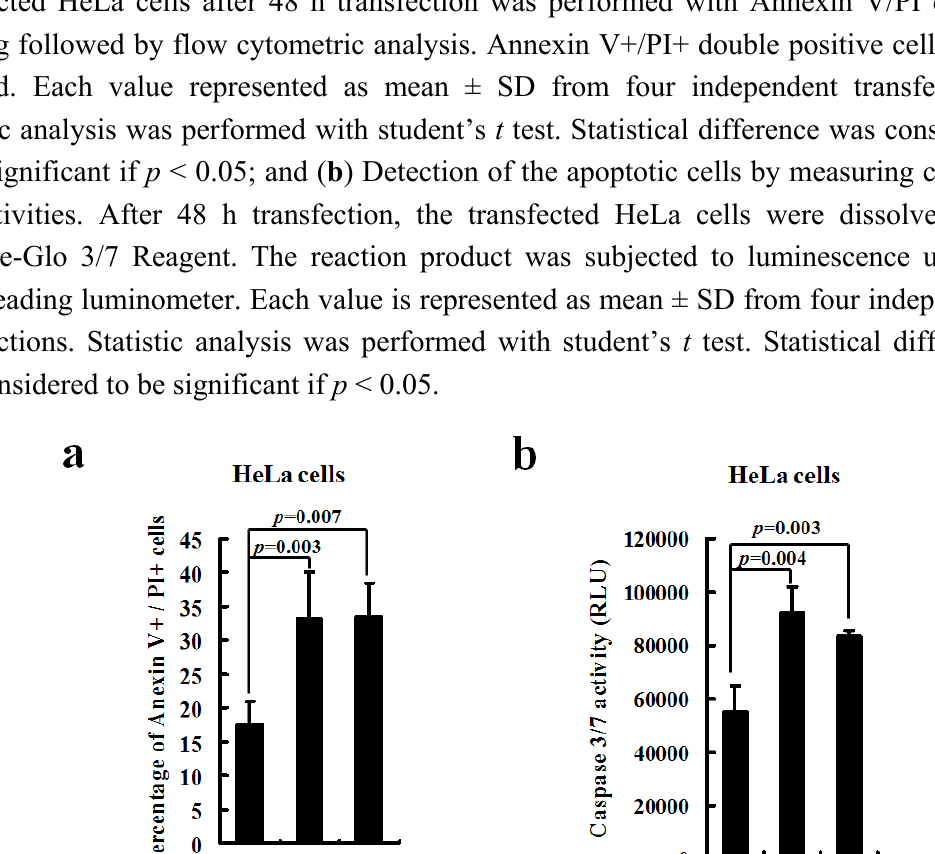
Figure 3. Human IL-23R induced cell apoptosis in human cervical cancer cell line HeLa cells. ( a ) Quantitation of late apoptotic cells. The detection of cell apoptosis in